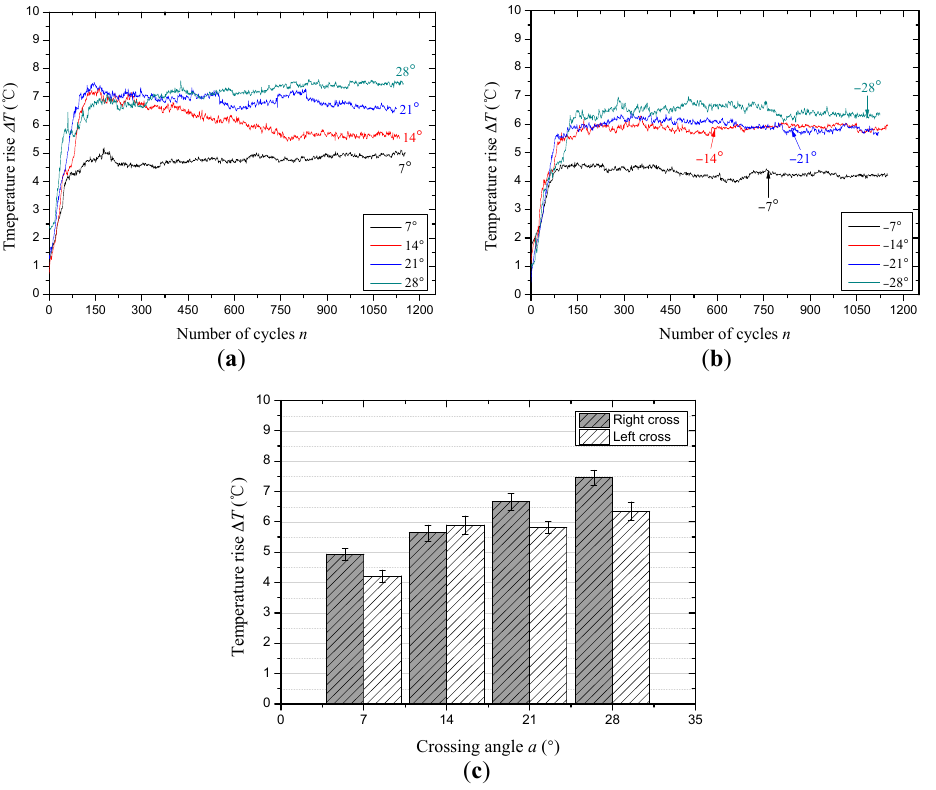
Figure 8. The evolution of the temperature rise under different sliding conditions ( x : 10 mm; v : 6 mm/s). ( a ) Right cross contact; ( b ) left cross contact; ( c ) the average values of the temperature rise in the steady-state period.